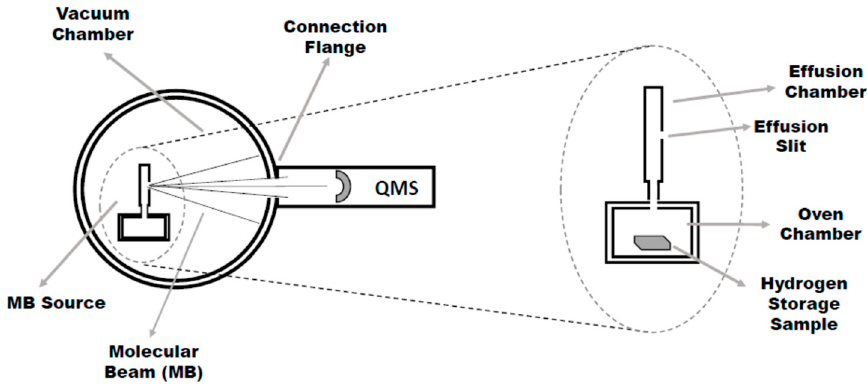
Figure 1. Molecular Beam-Thermal Desorption Spectrometry (MB-TDS)configuration (top view).